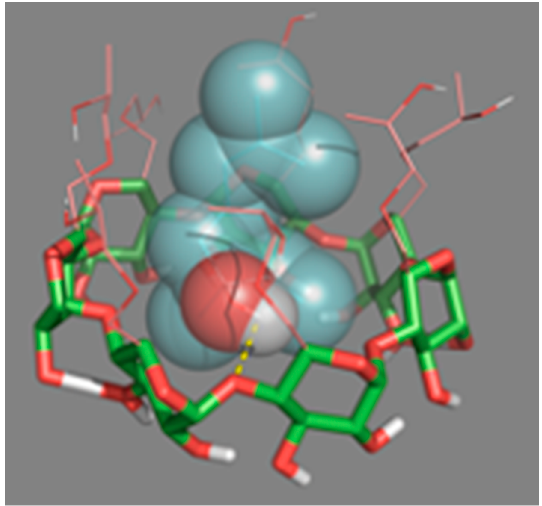
Figure 7. Three-dimensional perspective of the linalool-HP- β -CDs complexes obtained by Docking.